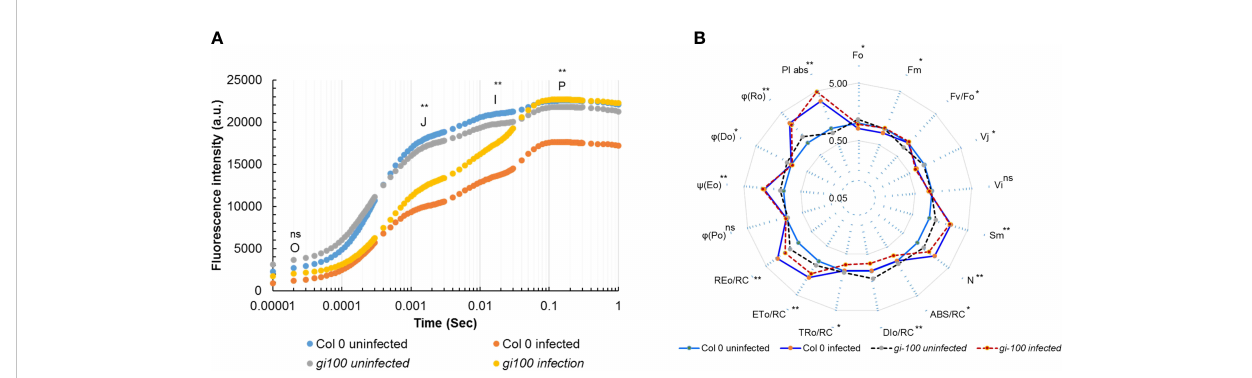
FIGURE 8 Effect of F. oxysporum on Chl a fl uorescence. Col-0 WT and gi-100 leaves were incubated at 24 DPI with the Multifunction Plant Ef fi ciency Analyzer (M-PEA) (Hansatech Instruments Ltd, UK) for obtaining chlorophyll. (A) Fluorescence intensity on OJIP transient curve. (B) Spider plot for Col-0 and gi-100 lines of A. thaliana plants 24 DPI with F. oxysporum with their respective control. Values are expressed as mean ± SD. Two-way analysis of variance (ANOVA) using Sidak ’ s multiple comparisons test was performed with the help of GraphPad Prism. * p < 0.05. ** p < 0.01, ns, Non-signi fi